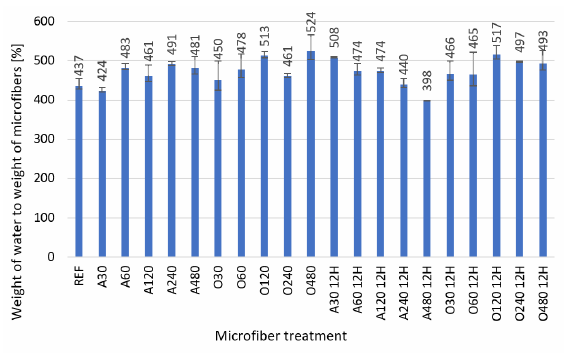
Figure 2. Wettability measured by the indirect Packed Cell method – reference microfibers (REF) microfibers after argon and oxygen plasma treatment (A, O), respective time in seconds (30, 60, 120, 240 and 480) and samples that were tested after 12 hours in a laboratory environment (12H).